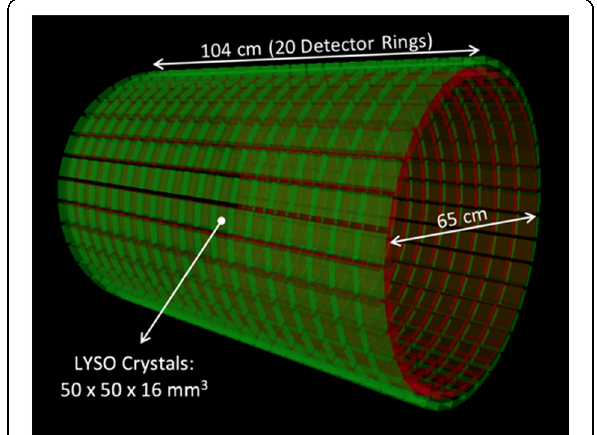
Fig. 1 (abstract A18). TB-PET with monolithic